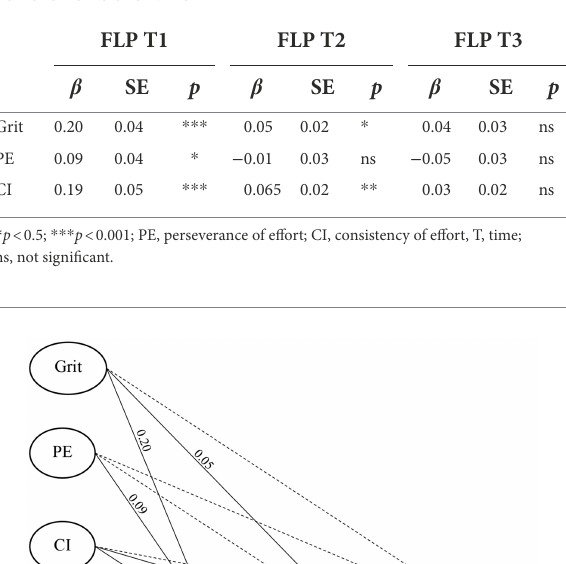
TABLE 6 Structural model based on bifactor CFA predicting language achievements over time.